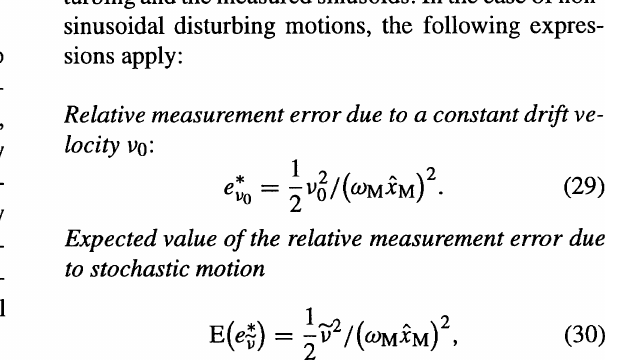
FIGURE 9 Damping rates of the relative error e s due to sinusoidal disturbing voltage as a function of the normalized trigger hysteresis (Eqs. (22), (23)). DS,E damping rate for s)' expected value E(e Ds m2 damping rate for variance s2., , e s UH trigger hysteresis, 12M signal amplitude, Us amplitude of the disturbing